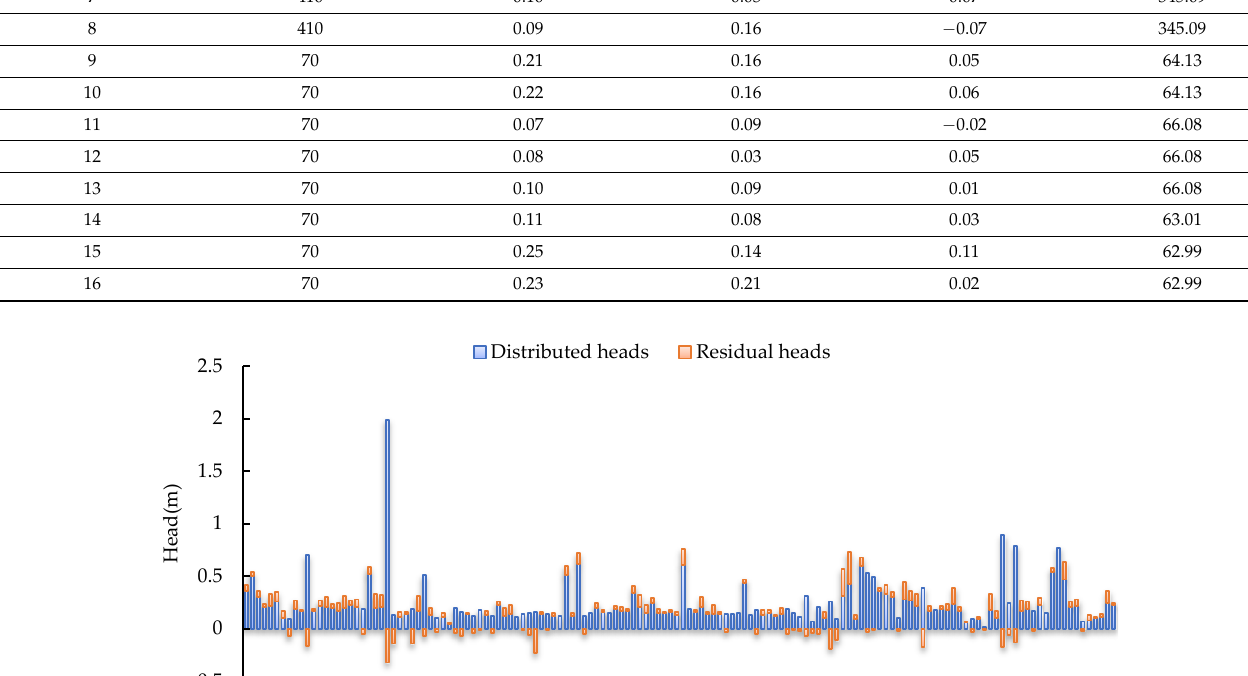
Table 3. Calculation results of head losses of crossing water-conveyance structures.